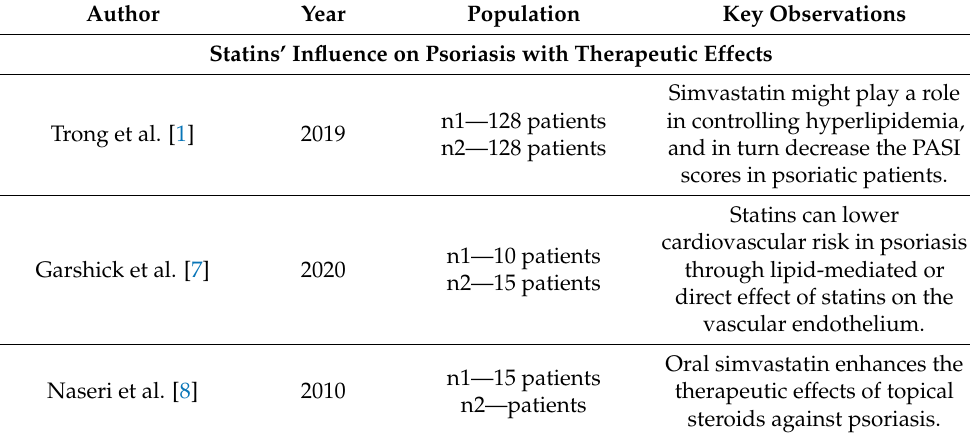
Table 1. Summary of the studies on statins’ influence on psoriasis with therapeutic